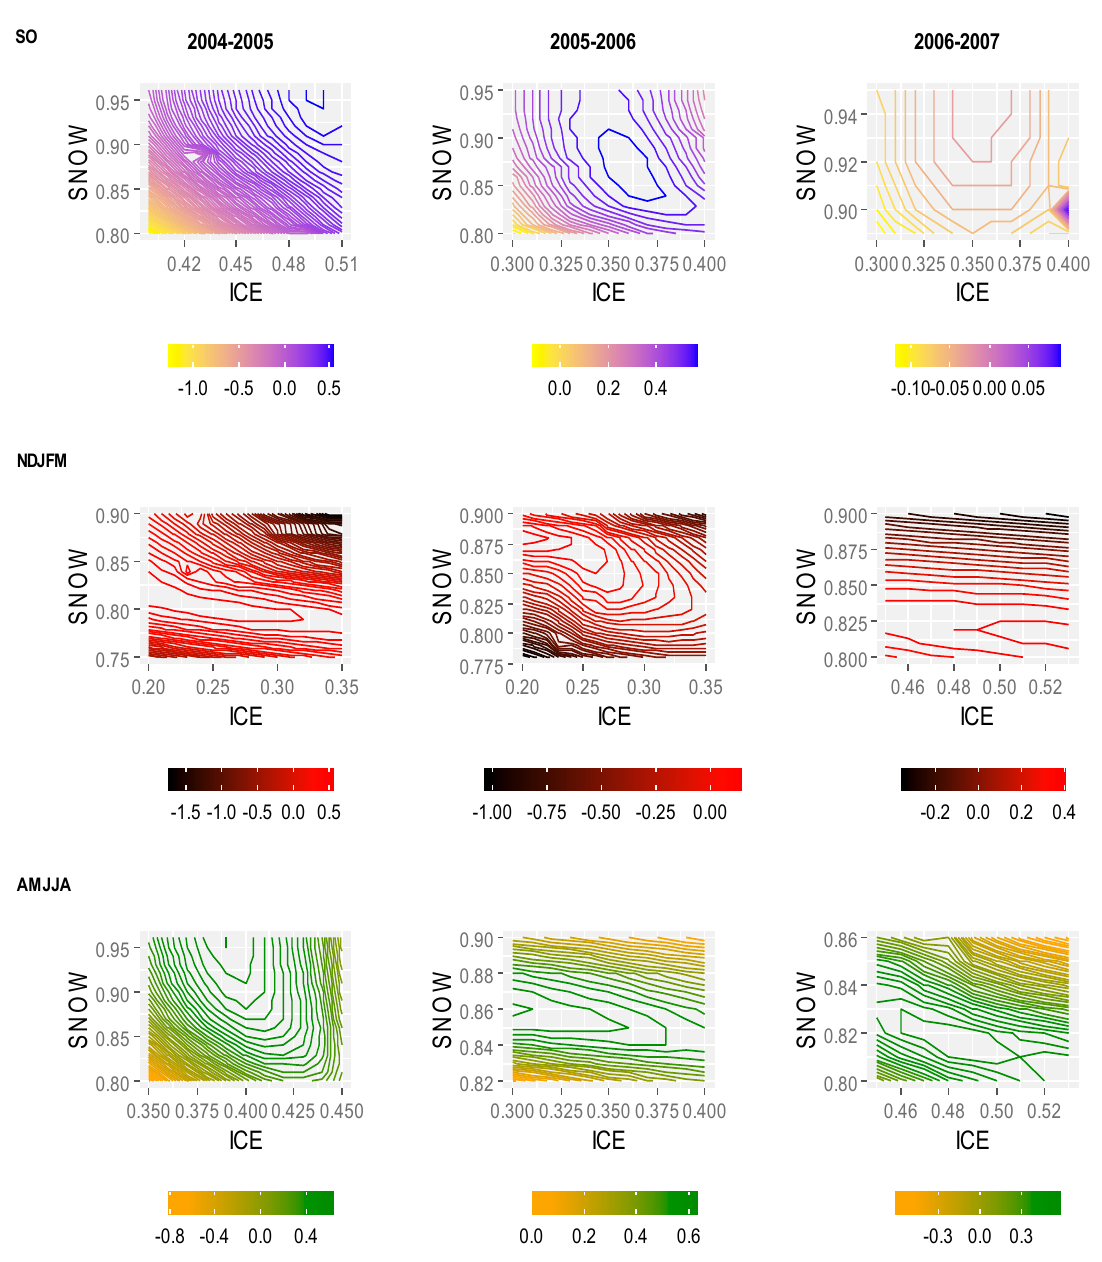
Figure 6. Seasonal snow and ice albedo sensitivities for the three hydrological years in terms of their E– response surfaces.